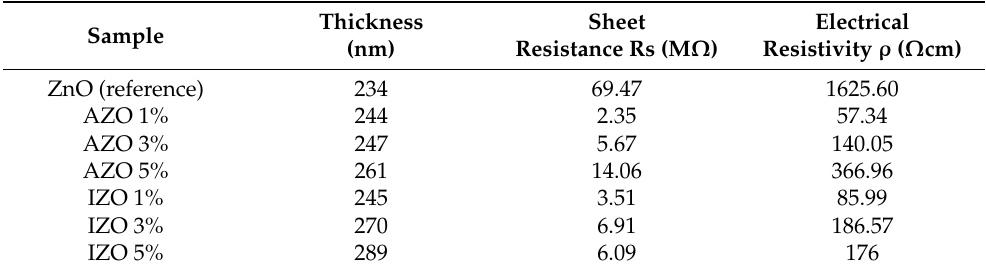
Table 5. The thickness and the calculated sheet resistance and electrical resistivity of undoped ZnO, AZO, and IZO thin